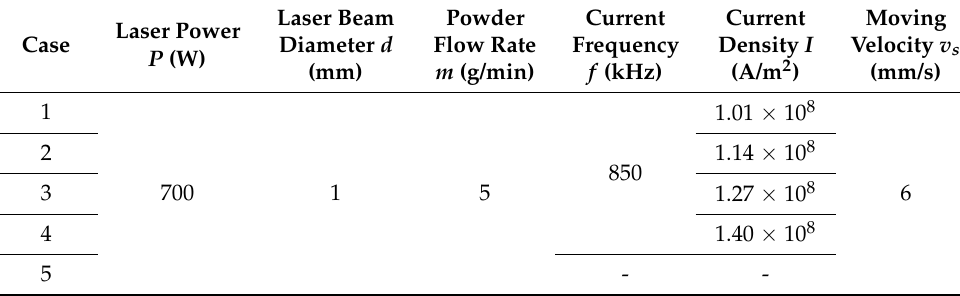
Table 2. Deposition parameters used in